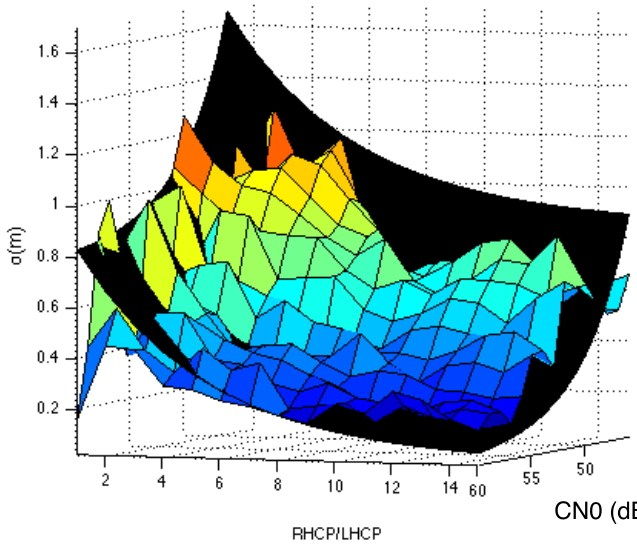
Figure 10. Least-Squares 3D fitting of the measured phase errors as a function of the RHCP to LHCP ratio and the CN0 of the RHCP component. Empirical data (colored) and fitted shape